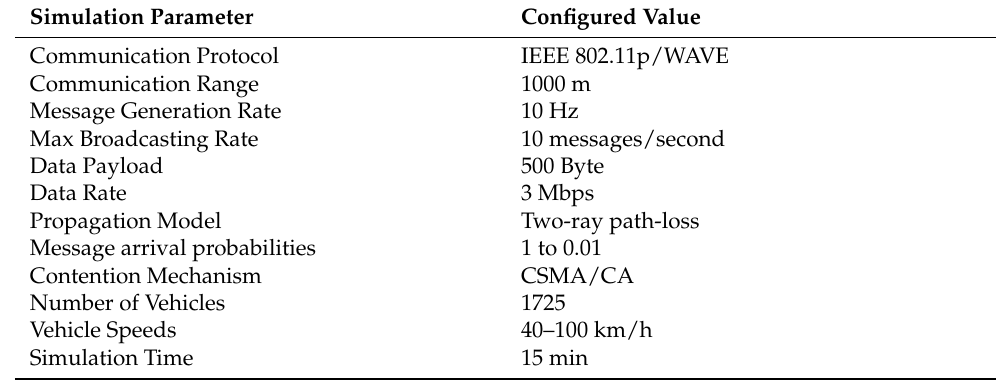
Table 2. Simulation parameters.